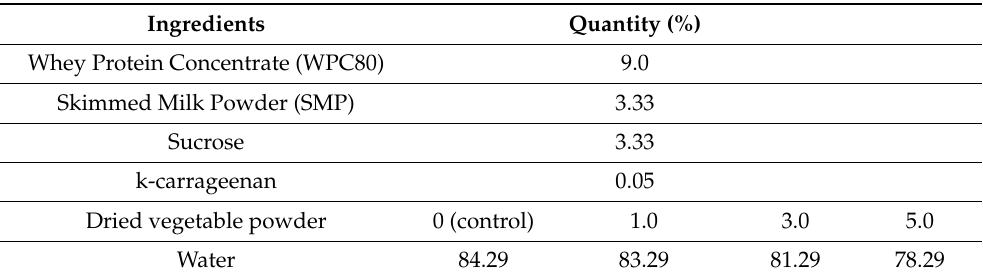
Table 1. Composition of fat-free consummate dairy desserts with the addition of dried vegetable